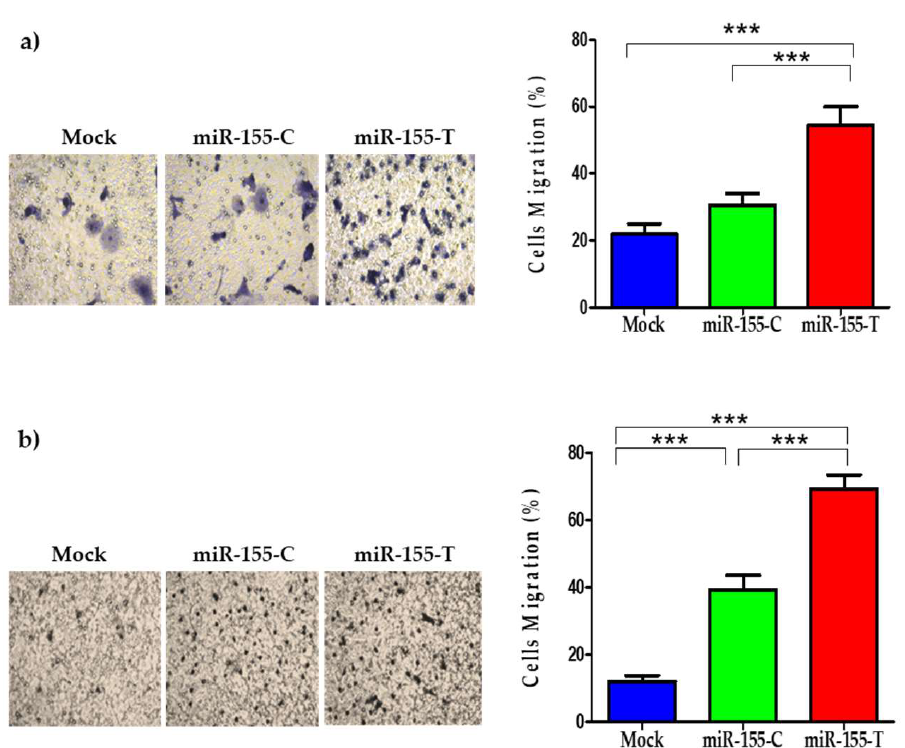
Figure 4. Migration capacity of BC cells expressing the miR-155-T allele. BC cell lines were transfected with miR-155-C, miR-155-T, or mock vectors, as indicated and grown for 24 h in complete media. Migration was evaluated at 8 h of incubation in a transwell assay. Pictures of 10 different fields were taken, and the number of cells was counted for each condition. Representative images of crystal violet-stained cells at 20 × magnification (left panels). Relative quantification of migrated cells (right) in which graphs show the average ± the standard error of migrated MDA-MB-231 ( a ) and MCF-7 ( b ) cells. The plotted values indicate the average of three independent experiments ± SD. *** p < 0.001.